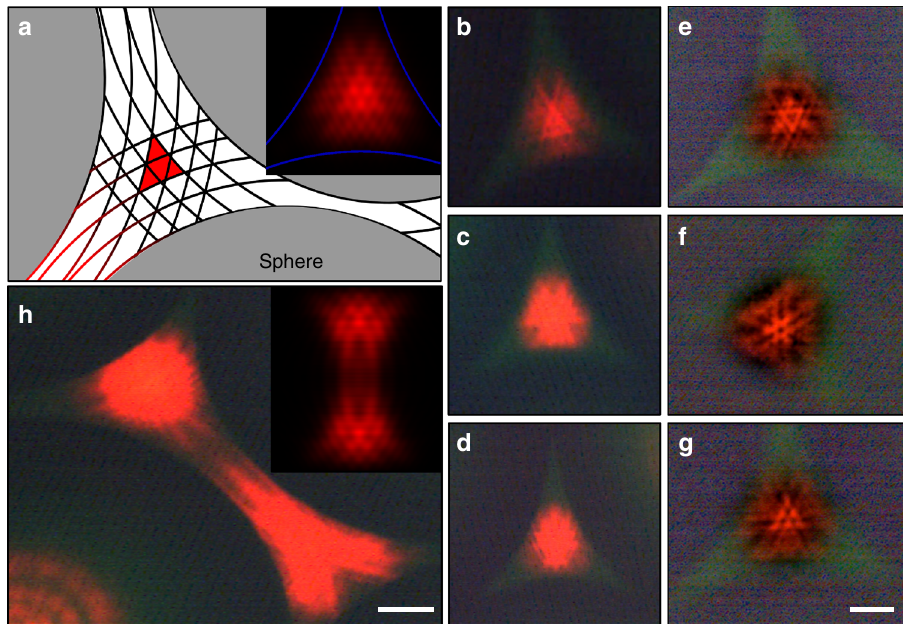
Fig. 3 Observed and calculated fractal laser modes for three and four microsphere topologies. a Illustration of a 3-sphere arrangement and its associated triangular fundamental laser mode (in red). The inset is the calculated modal intensity map, shown in false color. b – d Progression of laser mode development from an early stage to more fully developed fractals (the interiors of c and d are saturated), recorded with a 10 × objective. e – g Fractal laser modes observed with a 20 × microscope objective. h Optical micrograph of an open interstitial region, illustrating fractal laser mode coupling. The inset is a simulation of the interaction between fractal modes produced by a 4-sphere